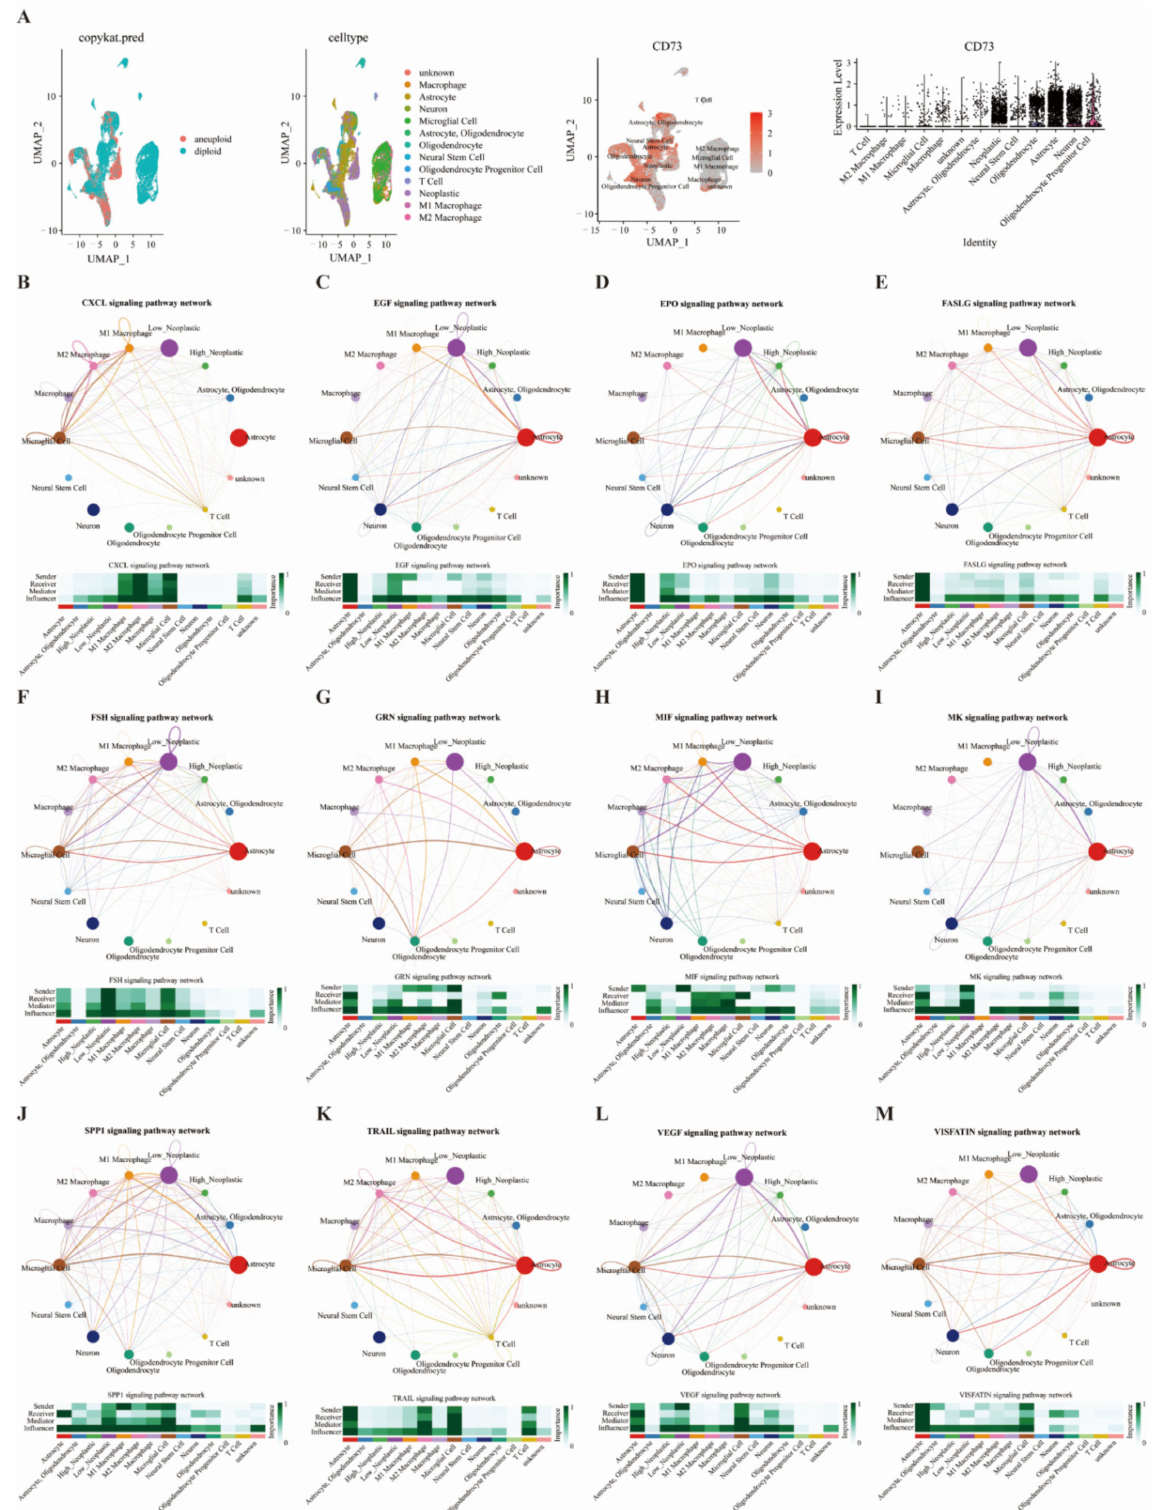
Figure 6. Single cell analysis shows that CD73 is closely related to immune cells and immune pathways in GBM. CD73 expression in microenvironment of GBM ( A ). Cross network diagram of signaling pathways between tumor cells and infiltrated cells based on CD73 expression ( B – M